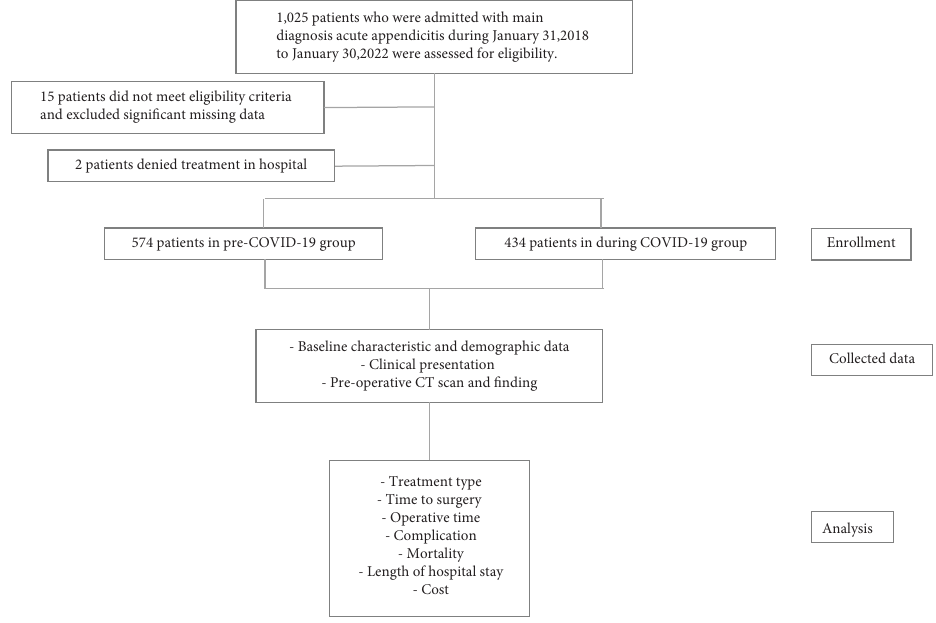
Figure 1: Te study fow diagram of the cohort